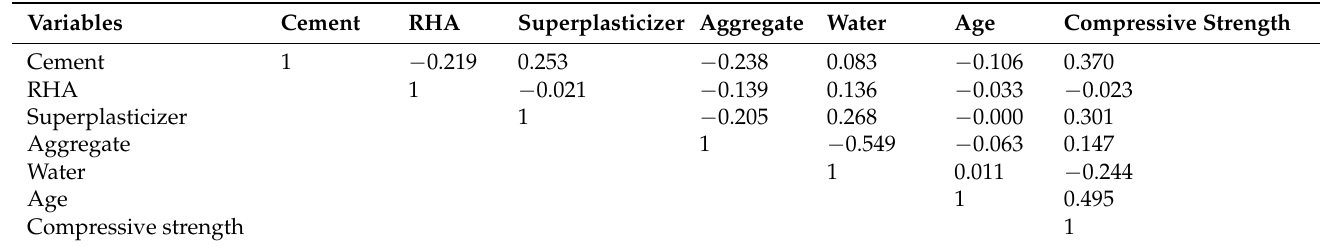
Table 2. Correlation coefficient values between all considered